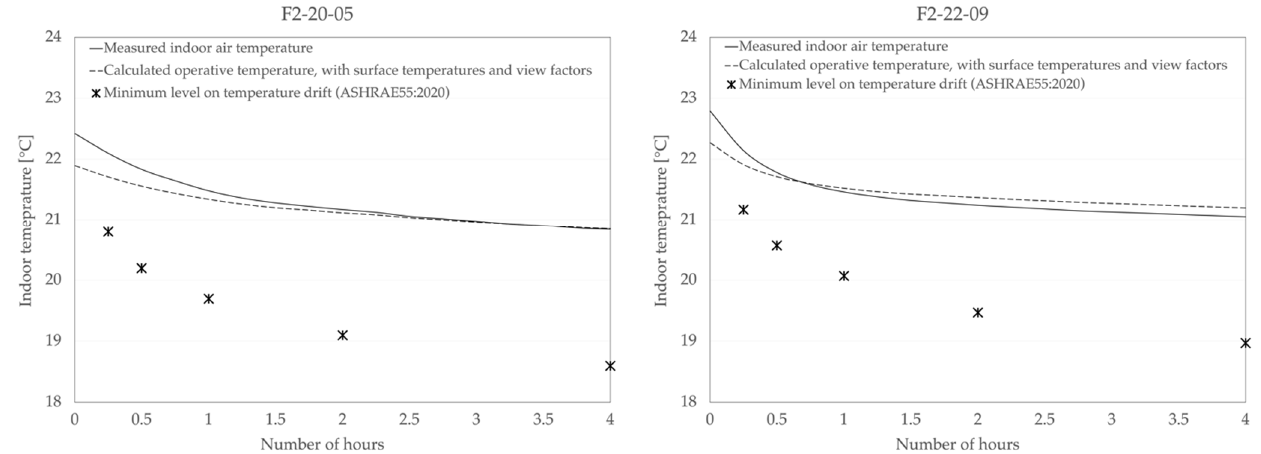
Figure 8. Temperature drift verification according to ASHRARE 55 2020 showing measured indoor air temperature and operative temperature T op,s , calculated using the mean radiant temperature from measured values of wall surfaces’ temperatures and view factors. Tests in flat 2: 2–05 March 2020 ( left ), 2–6 March 2022 ( right ).